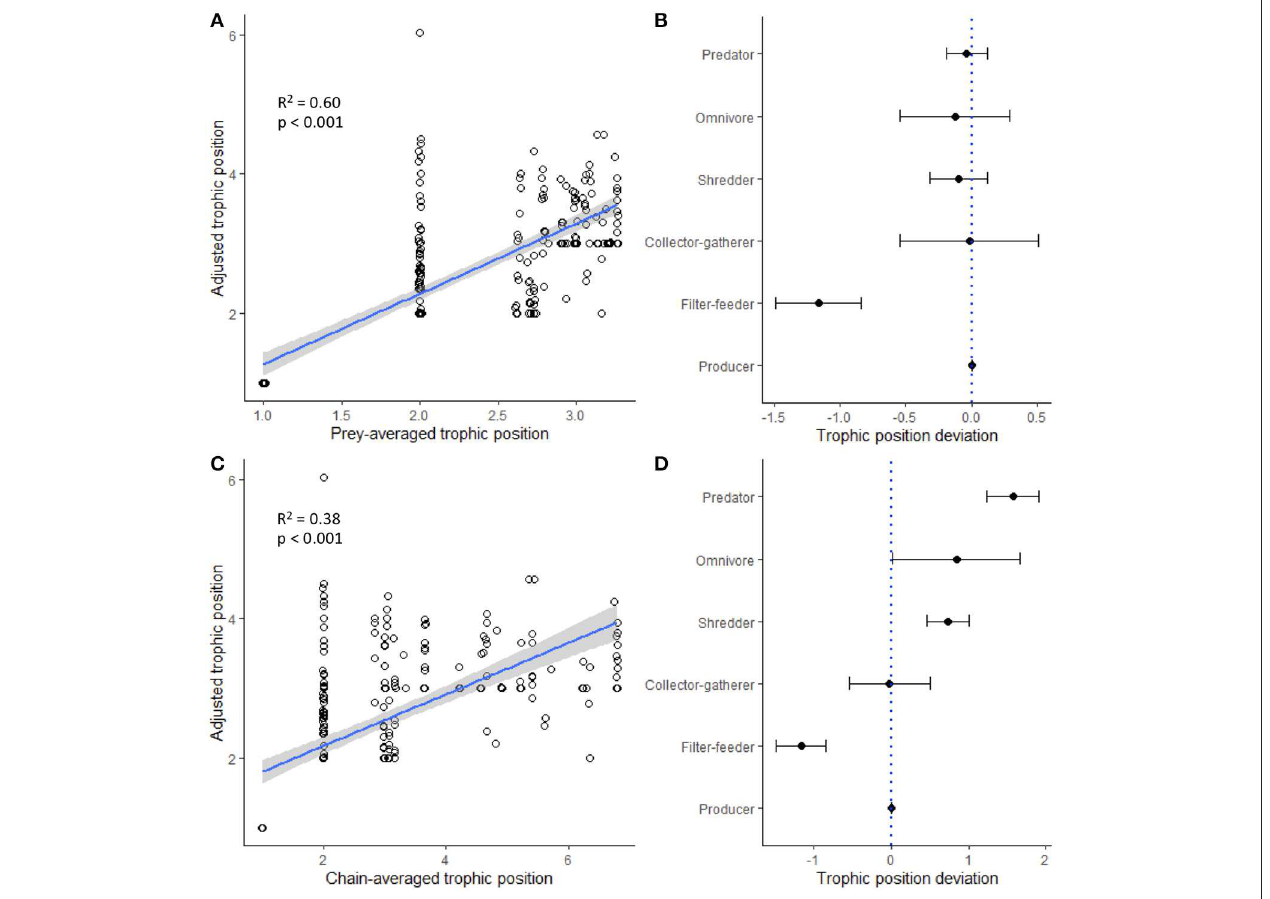
FIGURE 5 | Global linear regression models illustrating how well two heuristic food web estimates of trophic position [ (A) prey-averaged trophic position and (C) chain-averaged trophic position] predicted trophic position inferred from stable isotope analysis. Points have been jittered for visualization purposes. (B,D) Deviation of different functional feeding groups are indicated by black dots with 95% confidence intervals; negative values indicate when heuristic food web analysis underestimated stable isotope trophic position, and positive values indicate when heuristic food web analysis overestimated stable isotope trophic